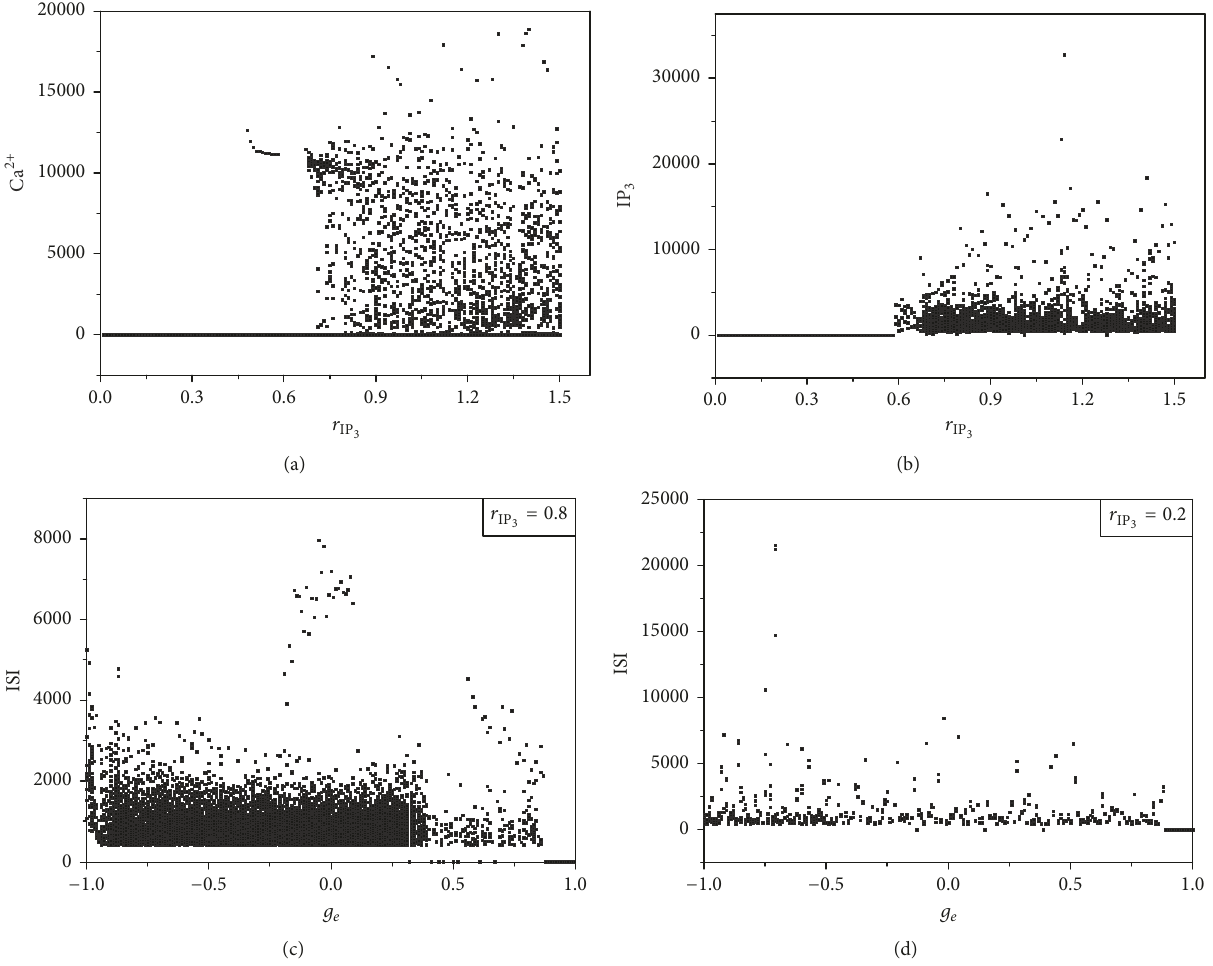
Figure 13: Bifurcation diagram for Ca 2+ , IP 3 , and ISI is calculated by setting different 𝑟 IP